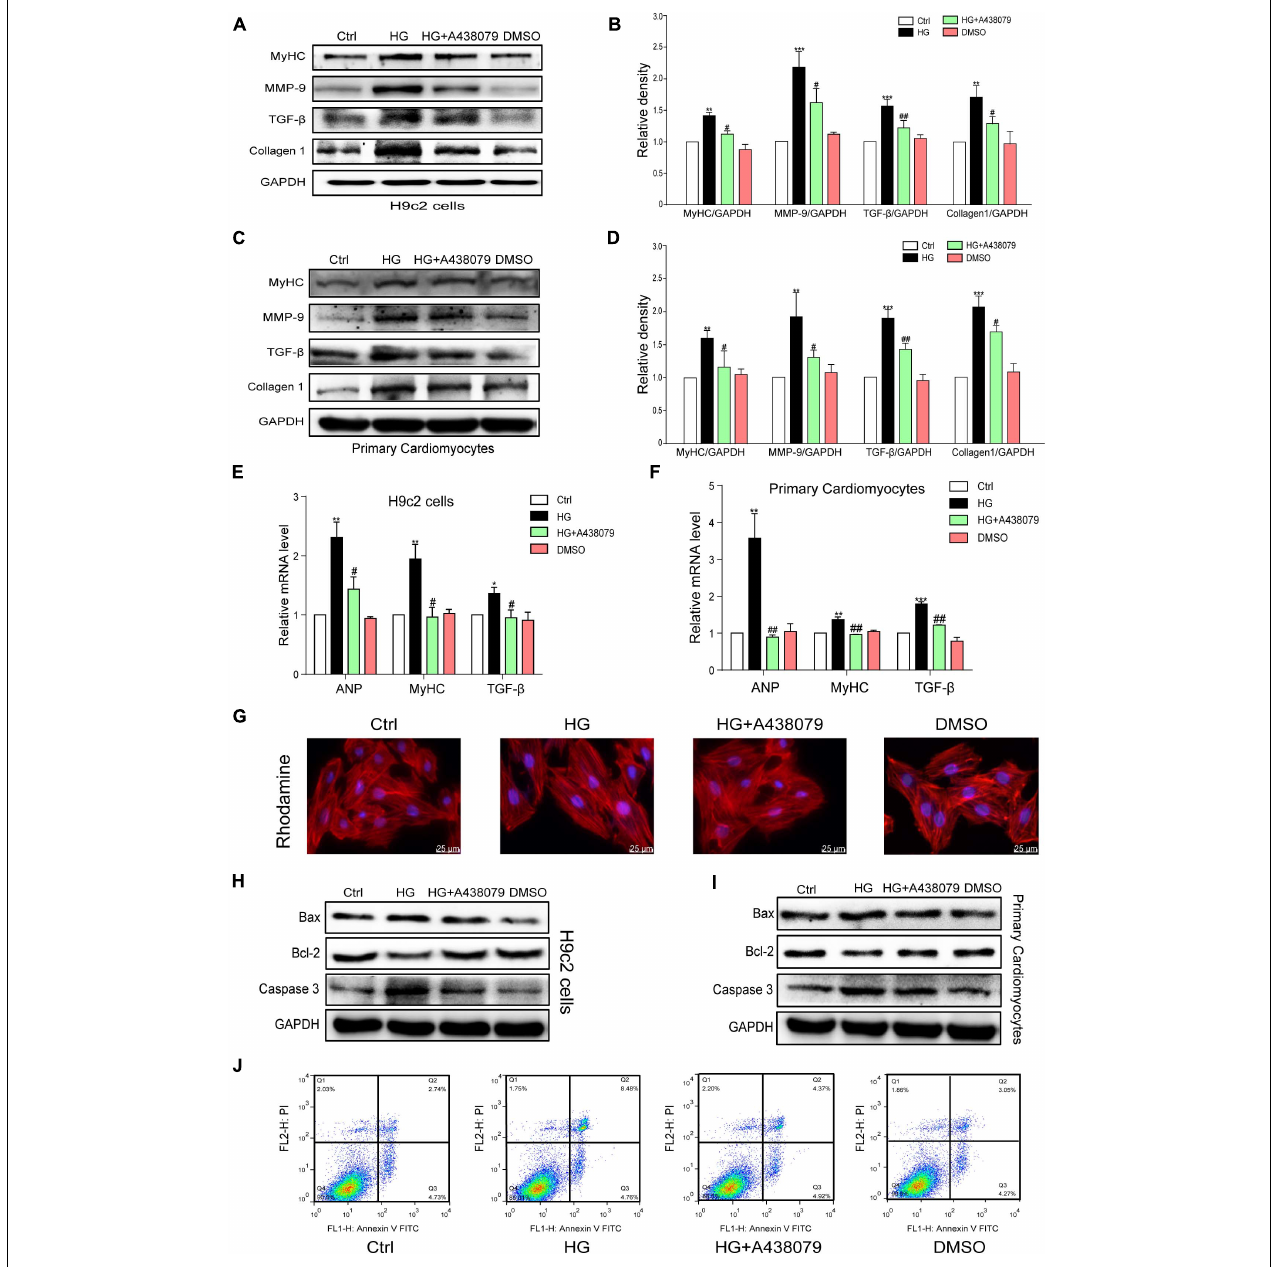
FIGURE 4 | P2X7 receptor inhibition prevented HG-induced phenotypic changes and apoptosis in H9c2 cells and rat primary cardiomyocytes. The levels of pro-fibrotic (MMP-9, TGF- β , and COL-1) and pro-hypertrophic proteins (MyHC) was examined using western blot analysis (A,B) . (E) The bar graph shows the corresponding PCR data for TGF- β , MYHC, and ANP. The same process and analysis were performed for rat primary cardiac myocytes. (WB: C,D , PCR: F ). Representative images of rhodamine staining in each group of H9c2 cells (G) . The levels of the apoptosis-related proteins Caspase-3, Bcl-2, and Bax were measured on H9c2 cells and primary cardiac myocytes using western blotting (H,I) . Flow cytometry analysis showing that A438079 reduced the apoptosis of HG-treated H9c2 cells (J) . (Data from three independent experiments were analyzed: * p < 0.05, ** p < 0.01, and *** p < 0.001 compared with the Ctrl; # p < 0.05, ## p < 0.01, and ### p < 0.001 compared with STZ alone).